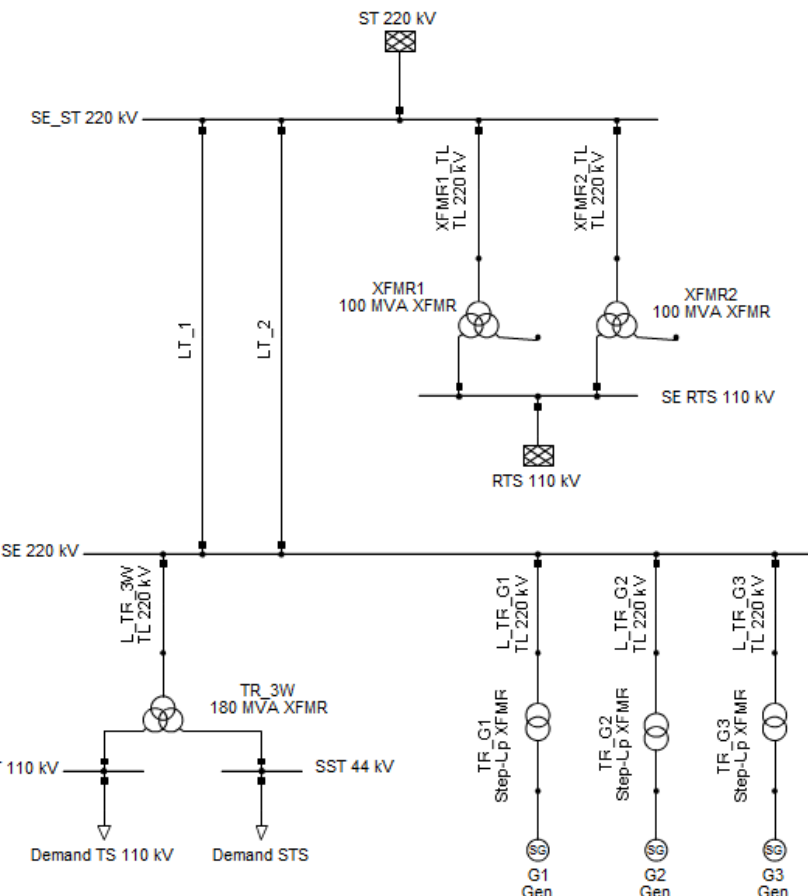
Figure 6. One-line drawing of the sample transmission system used to test the proposed solution strategy. Energies 2019 , 12 , x FOR PEER REVIEW